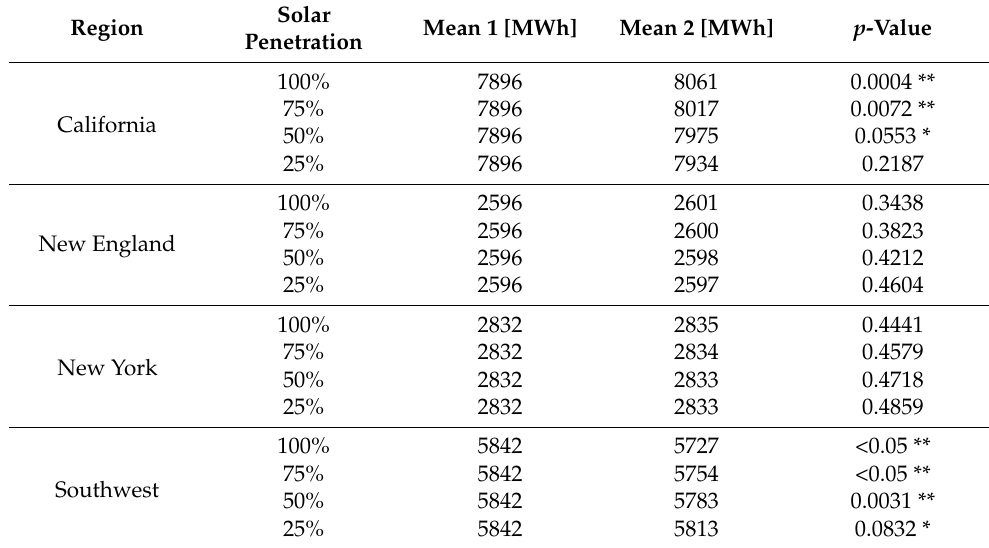
Table 9. Hypothesis 3— t -test results by region and level of solar penetration. Region